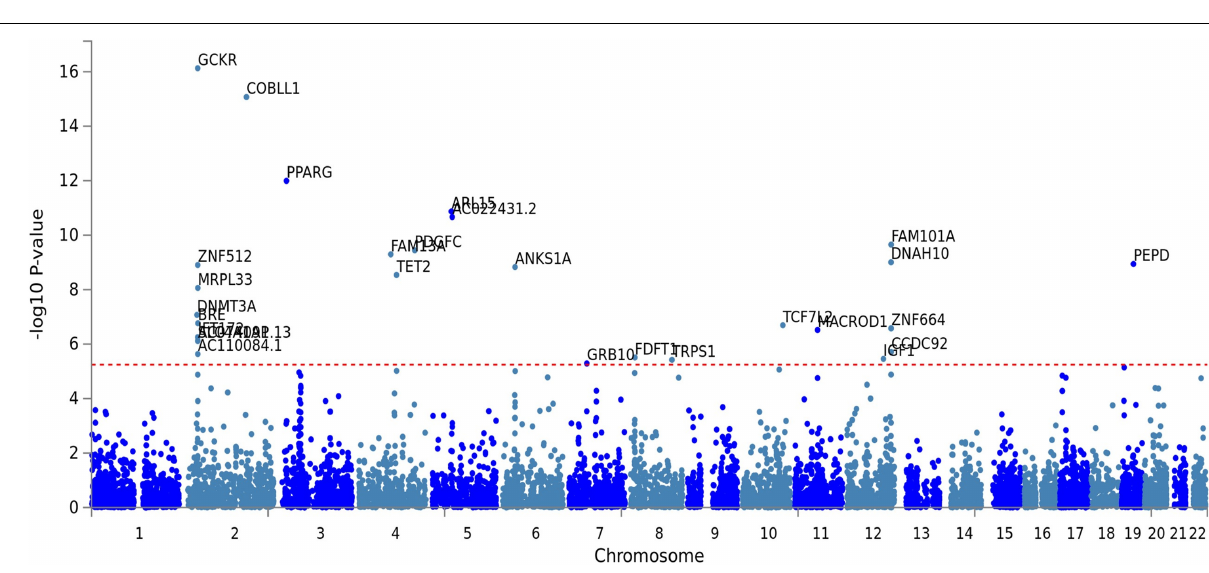
FIGURE 3 | Genome-wide association study (GWAS) for fasting insulin from the Meta-Analyses of Glucose and Insulin-related traits Consortium (MAGIC). Each dot represents a single nucleotide polymorphism (SNP), with the x -axis showing genomic location and the y -axis showing the association level of each respective loci to fasting insulin. The gene names for all significant SNPs are displayed in the plot. This plot was obtained from